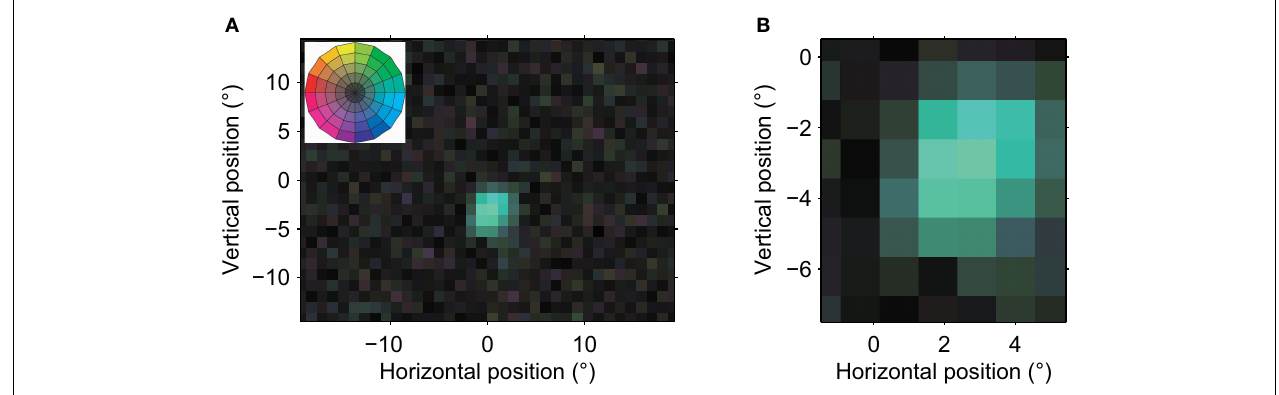
shows that only a single, restricted region of visual space consistently led to spikes from this neuron; its spatial receptive field was contiguous. (B) This close-up view of the receptive field shows the relatively homogenous direction preference within the receptive field. None of the preferred directions differed significantly from each other (bootstrap, p > 0.05).This neuron had a strong preference for motion to the right (blue-green) in the center of its receptive field.The strength of direction tuning gradually decreased toward the edges of its RF.The properties of this neuron corresponded well with the classical view of an MT neuron as a detector of a single direction of motion in a single, contiguous part of the visual field.